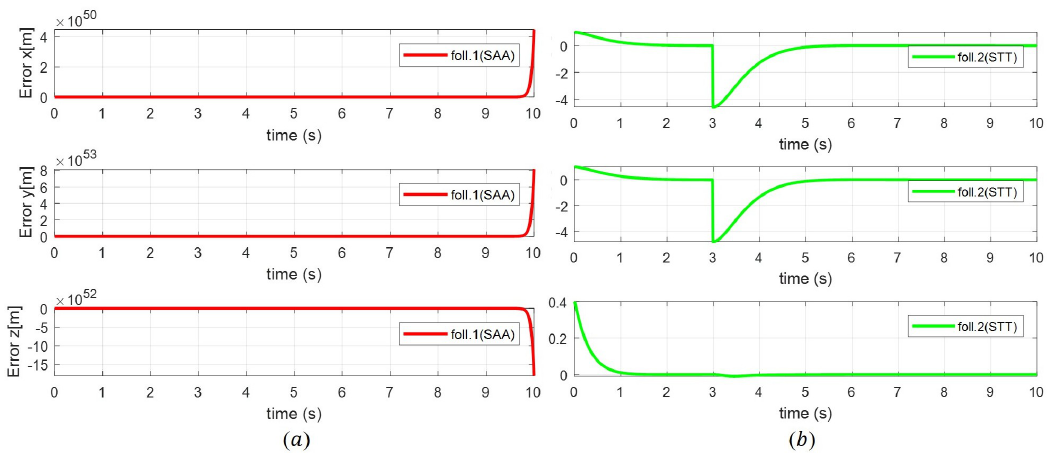
Figure 21. The formation errors with disturbance: ( a ) backstepping-based formation control with SAA; ( b ) proposed formation control with the state transformation